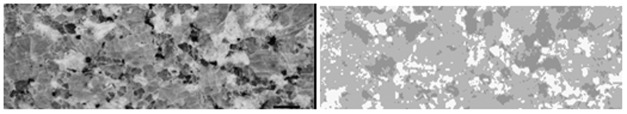
(a) Digital image of coarse grain and (b) Simulation model based on digital image of specimen.